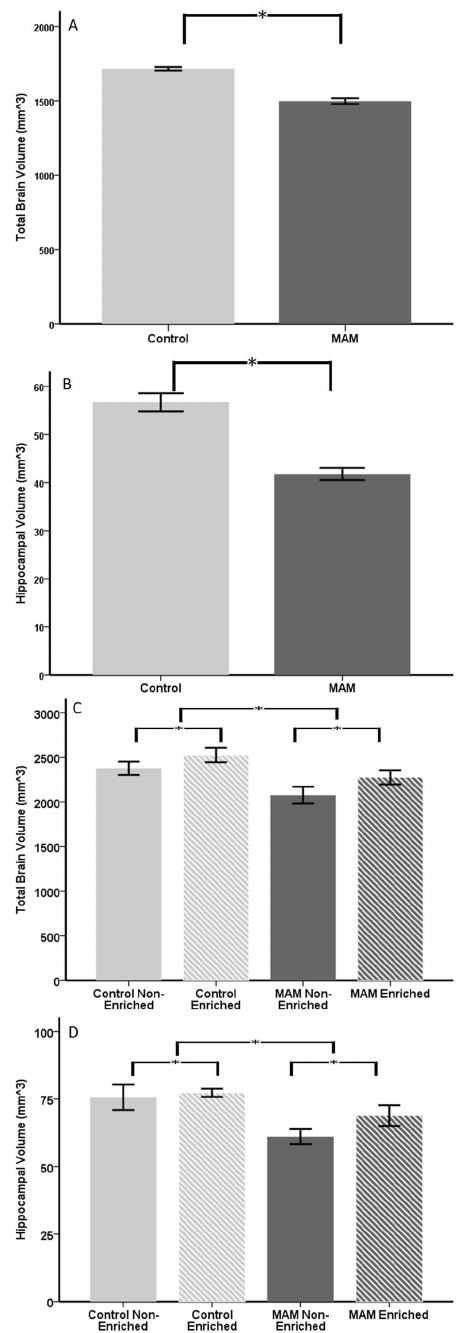
Figure 6. MRI data of MAM and control, enriched and non- enriched. At P22 MAM rats had significantly smaller total brain volume ( A , p<0.001) and hippocampal volume ( B , p<0.001). At P150, animals had undergone 128 days of either enrichment or non-enrichment. The effect of MAM was present in both total brain volume ( C , p=0.015) and hippocampal volume ( D , p<0.001). Enrichment increased total brain volume ( C , p=0.024) and hippocampal volume ( D , p=0.026) in both control and MAM animals. Error bars represent standard error.